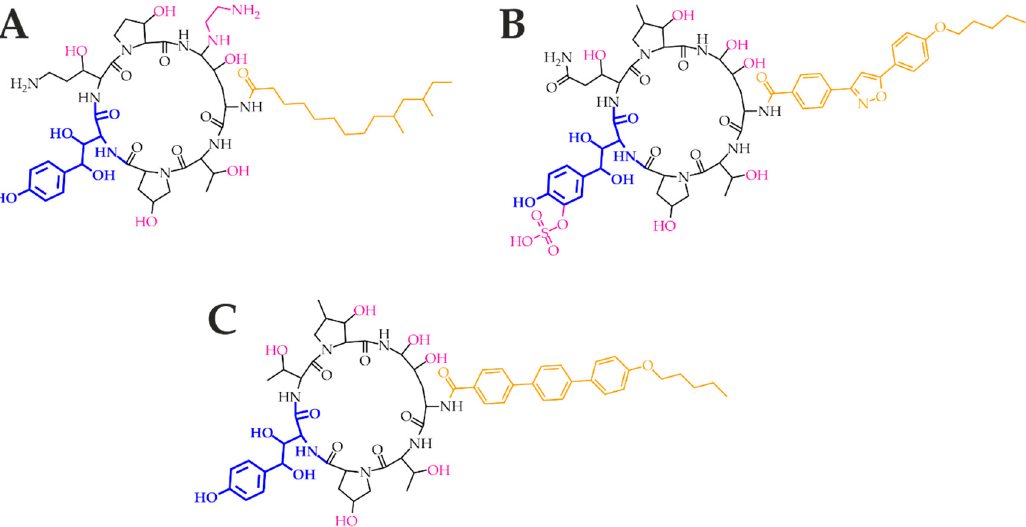
Figure 4. Echinocandins caspofungin ( A ), micafungin ( B ), and anidulafungin ( C ). The homotyrosine amino acid residue (blue) is mandatory for the inhibition of the 1,3- β - D -glucan synthase catalytic subunit Fks. The amino acid core (black) contributes to the antifungal potency and determines the physicochemical properties. Moreover, ethylenediamine, sulphate and hydroxyl groups (pink) contribute to water solubility. Specific lipophilic side chains (orange) decrease the hemolytic activity.